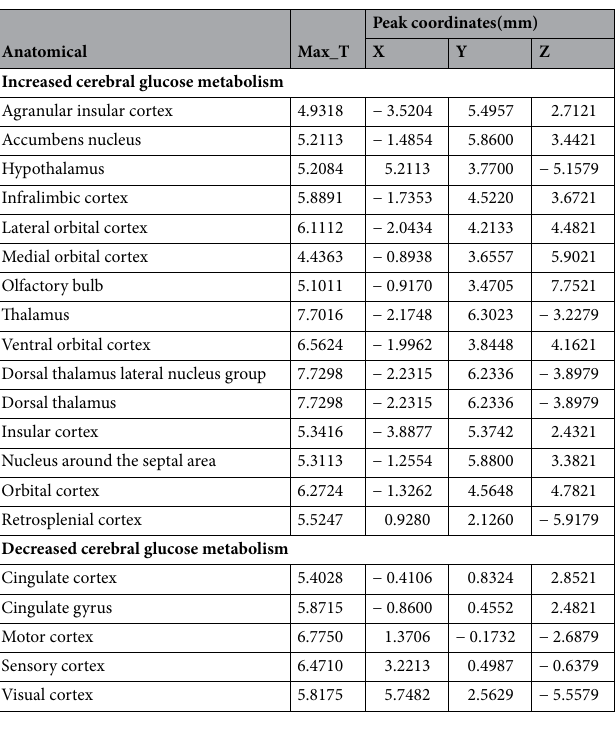
Table 2. Changes in brain glucose metabolism in the SHR group versus the WKY group.